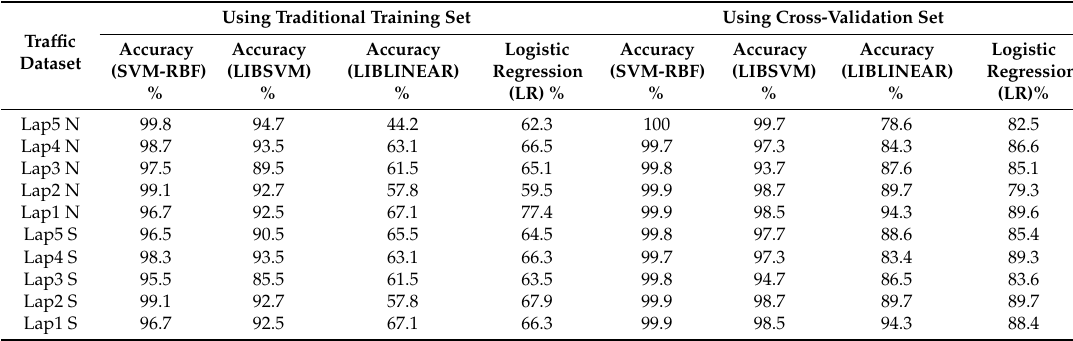
Table 5. Accuracy measures among SVMs. “N” and “S” in the Traffic Dataset column indicate northbound and southbound directions, respectively.